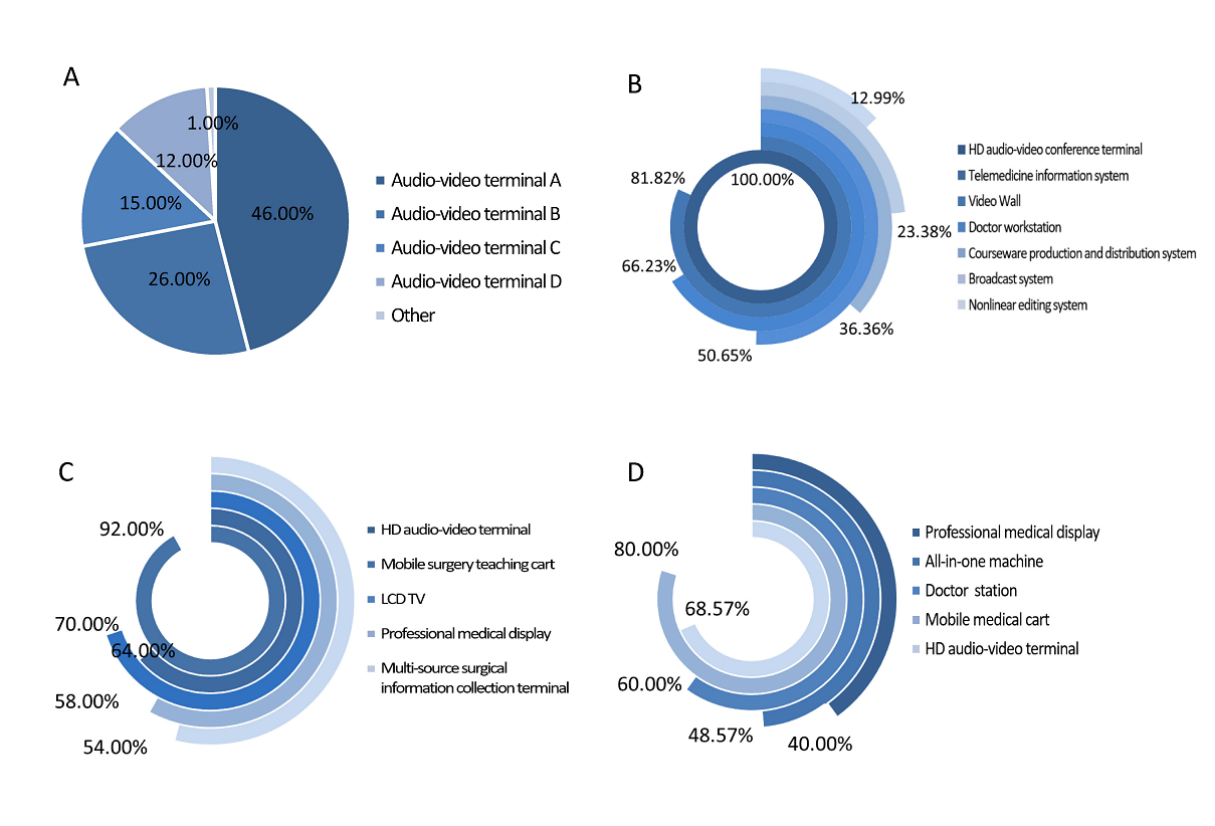
Figure 5. Hardware and software equipment for telemedicine services in the tertiary hospitals of China. A. Types of high-definition (HD) audio and video terminals for teleconsultation in tertiary hospitals; B. Hardware and software device configuration for remote education in tertiary hospitals; C. Hardware device configuration for remote surgery teaching in tertiary hospitals; D. Hardware device configuration for remote ward rounds in tertiary